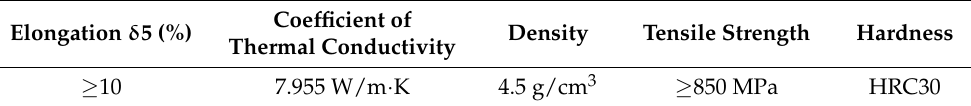
Table 4. Physical and mechanical properties of TC4 titanium